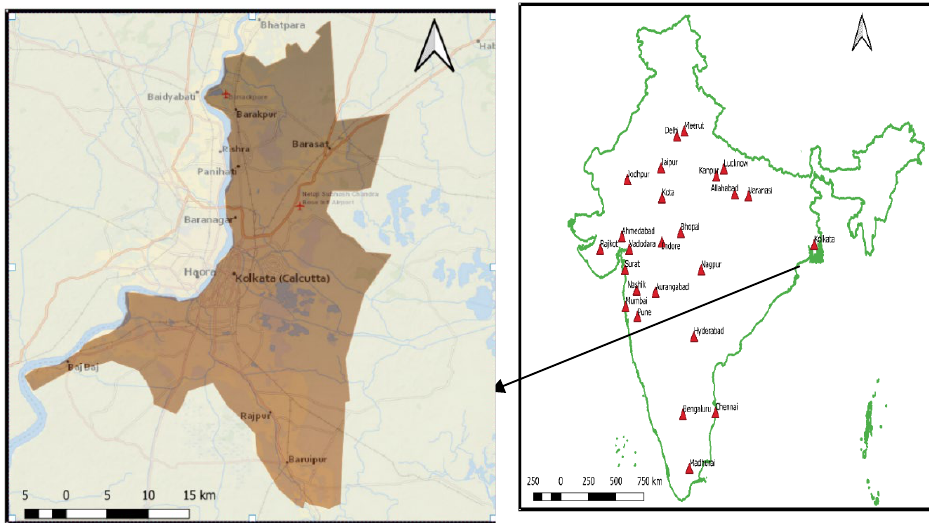
Fig. 1. Kolkata and 24 other million-plus Indian